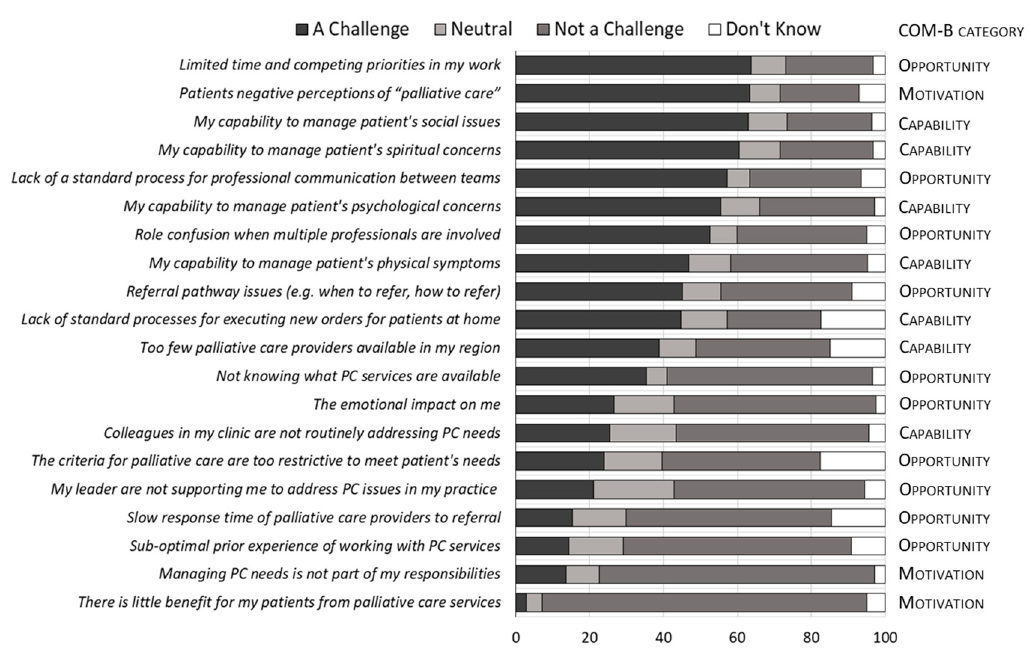
Figure 1. Oncology clinicians most frequently identified challenges to early, systematic, oncology-integrated palliative care for advanced cancer patients. Survey questions were posed using an ordinal scale (1–7) and framed as follows: “a challenge I face is:”. All agree responses (entirely = 7; mostly = 6; somewhat = 5) were collapsed as “challenge”. All disagree responses (entirely = 1, mostly = 2; somewhat = 3) were collapsed as “not a challenge”. Neither agree nor disagree responses were labelled “neutral” = 4. Survey questions are ranked by the percentage of observed “challenge” responses (largest to smallest). Questions are mapped to Michie’s Capability, Opportunity, and Motivation (COM) Behaviour (COM-B) Change Wheel.